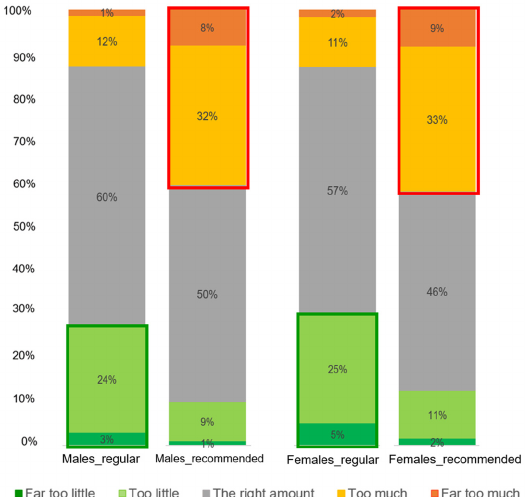
Figure 6. Bar plots of the evaluation of perceived amount of vegetables in regular and recommended portion sizes across the five meals by gender.